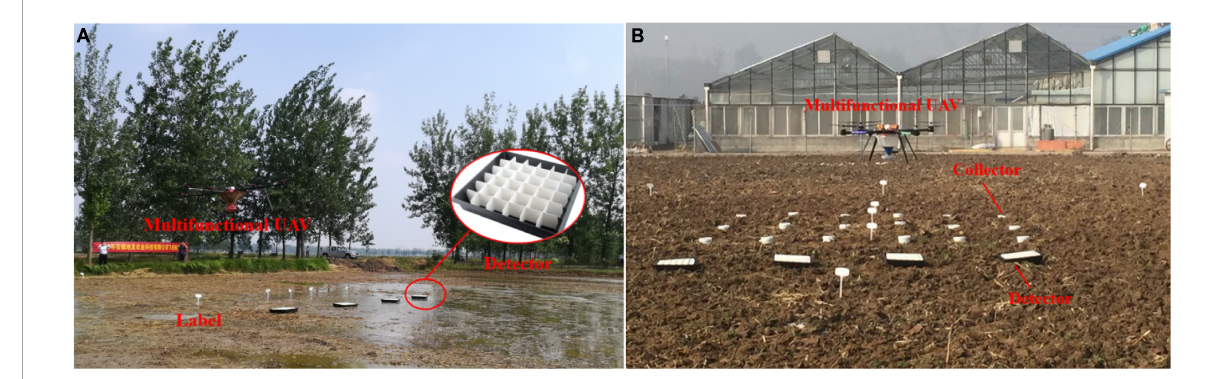
FIGURE5 Test site for rice seeding and fertilization. (A) Represents the rice seeding test site, where detector is to collect the rice seeds that fall on the ground; Label is to identify the location. (B) Represents the fertilizer spreading test site, where detector is used to collect ground fertilizer particles, and collector is used as another way to collect ground fertilizer